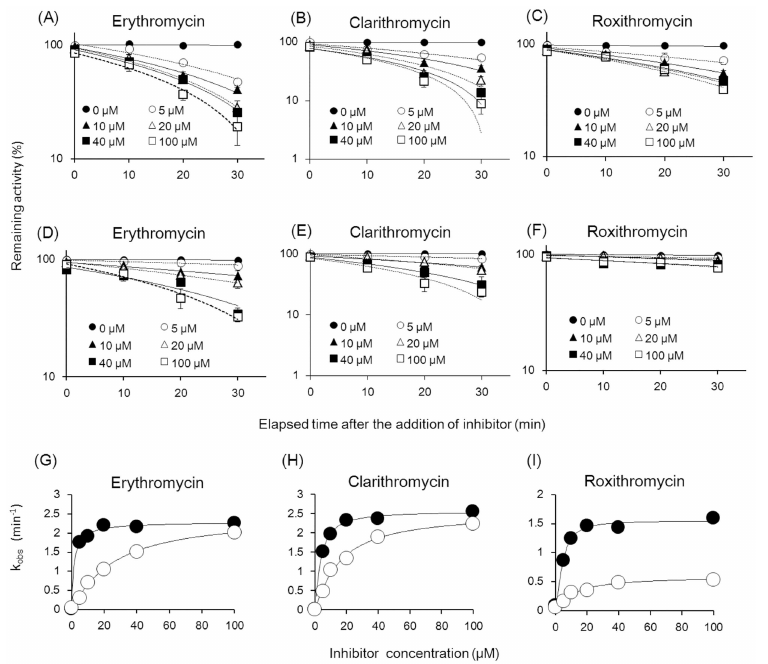
Fig 6. Inhibitory effects of macrolides on CYP-mediatedmetabolism in TC-HepG2 cells. (A), (B), (C) CYP3A-specific metabolismof clarithromycin, erythromycin, and roxithromycin, respectively,in TC-HepG2 cells. (D), (E), (F) CYP3A-specific metabolismof clarithromycin, erythromycin, and roxithromycin, respectively, in human hepatocytes. Macrolides (0–100 μ M/L) were preincubated at 37˚C for 0–30min, and the reactionwas initiatedby the additionof CYP3A-specific substrate for 30 min. (G—I) Apparentinactivation rate (k obs ) was estimated graphicallyfrom the slope of the plot for the natural log enzyme activity remaining after preincubation against preincubation time and was corrected for any loss of activity in the absenceof the inhibitor.k inact and K i,app values were obtained from a doublereciprocal plot of k obs against inhibitor concentration. Closedcircles representTC-HepG2 cells, and openedcircles represent parentalHepG2 cells. Each symbol represents the averageof triplicate determinations.